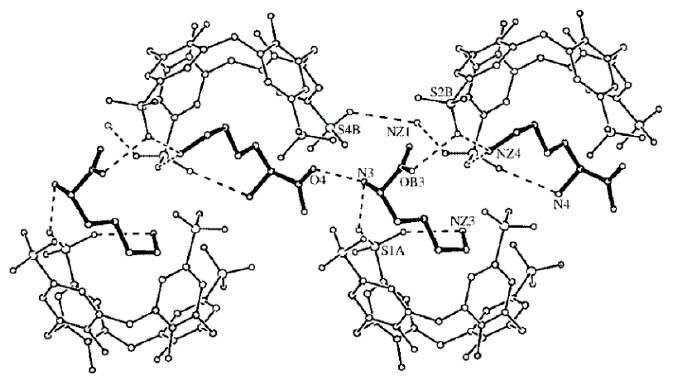
Figure 3. Crystallographic structure of the SC4- L -Lysine: the analyte (in bold) complexes in a parallel position to the calixarenes, as it can be observed by the two top complexes; another possible conformation is perpendicular to the disposition of the calixarenes, interacting not only with the calixarene at the bottom but having its ε -amino group, NZ1, interacting externally with the sulfonate groups of the top layer receptors. Reprinted with permission from [76]. Copyright (2000) The Royal Society of